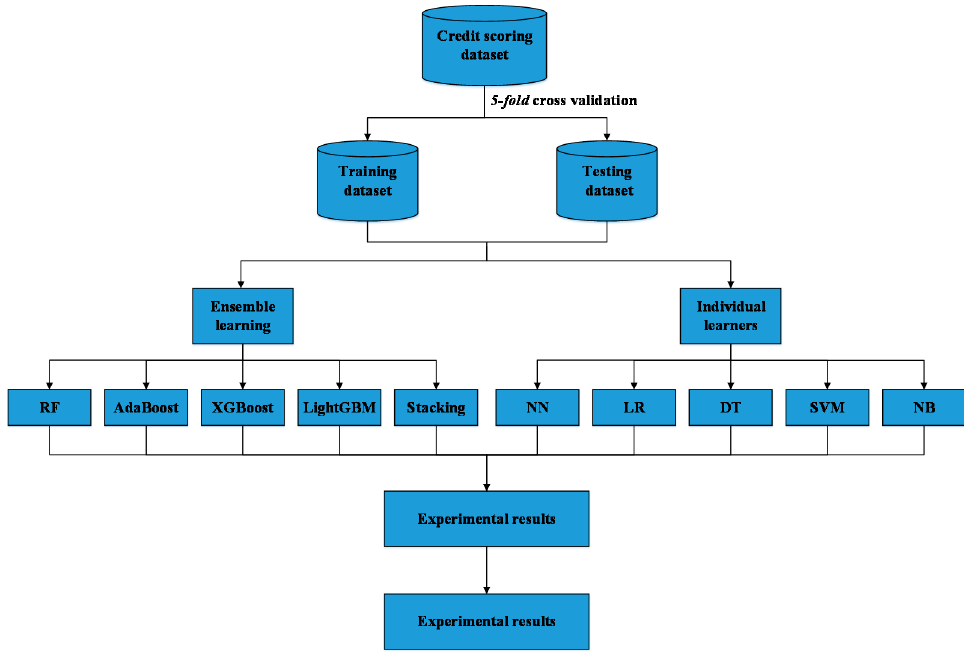
Figure 9. Experimental procedure.